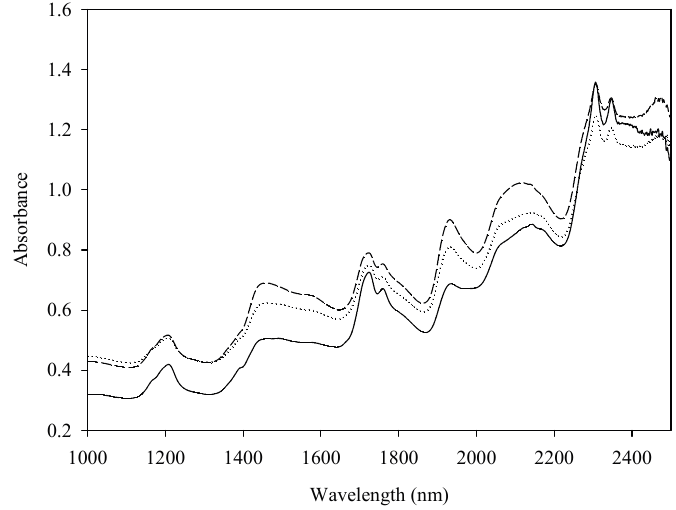
Figure 1. Average absorbance of C. vulgaris (long dash line), C. protothecoides (dotted line) and C. zofingiensis (solid line) samples over the range 1000–2500